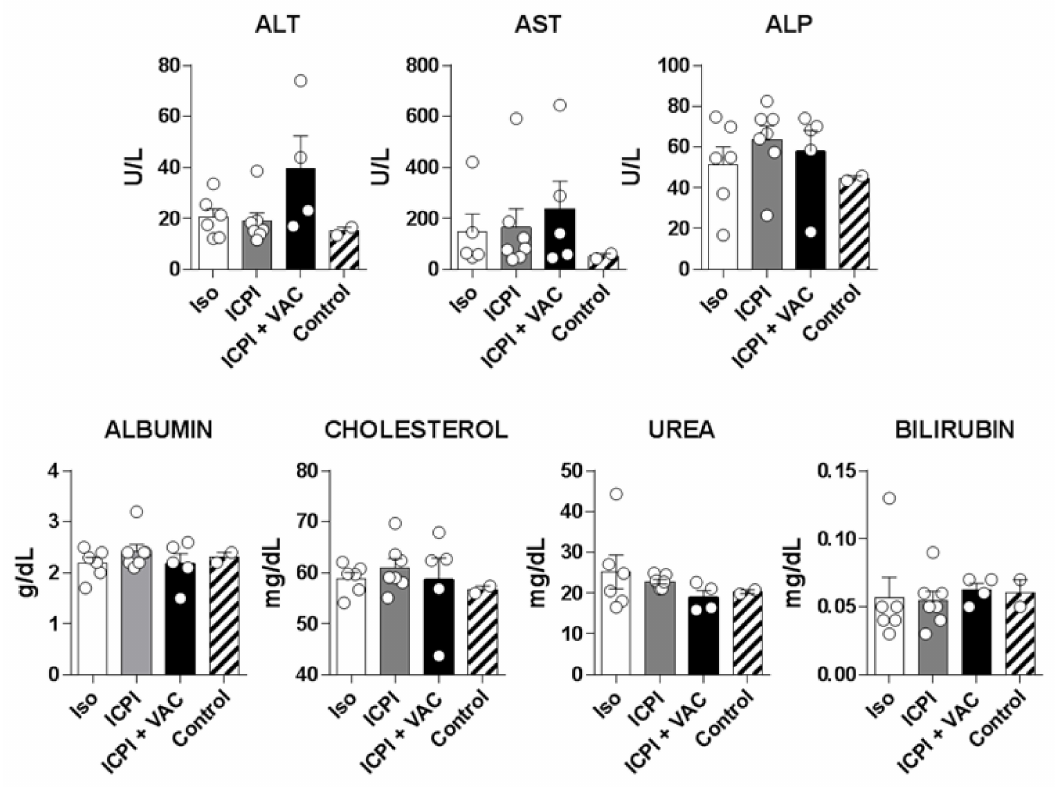
Figure6. CombinationoftheCIRP-basedvaccinewithICPIdoesnotenhancelivertoxicity. C57Bl6 / Jmice ( n = 5 / group) with hepatic B16-OVA tumors were treated with isotype or ICPI antibodies, with the combination of ICPI and OVA-CIRP and serum was obtained after treatment completion. As control, serum was obtained from two mice without tumors. Hepatic enzymes and liver-associated markers were measured in